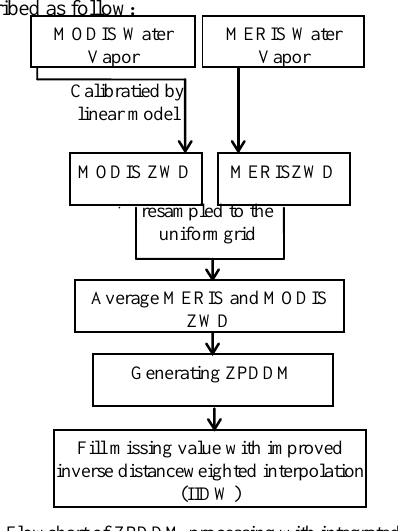
Figure6. Flowchart of ZPDDM processing with integrated MERIS and MODIS